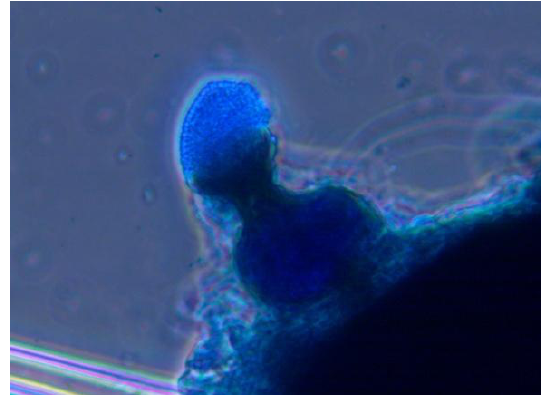
Figure 6. Pycnidia of the fungus Phoma sp. located on body of hemlock woolly adelgid, cotton blue stain, objective